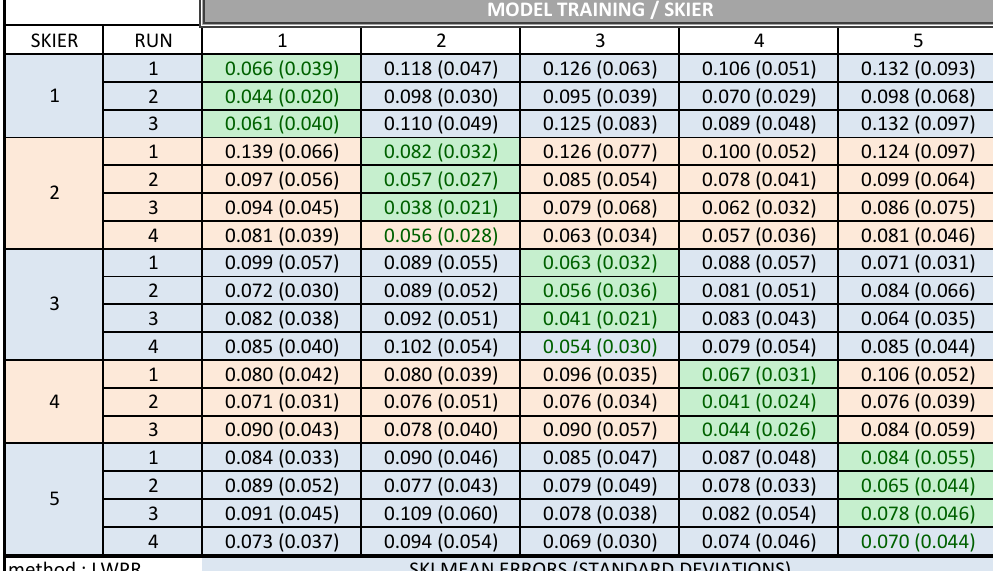
Table 4. Cross-validation of LWPR models. Models were learned using all runs of the same skier (columns). Mean errors and standard deviations of the positions of the skis for these models were calculated for all 18 runs. All values in the table are given in